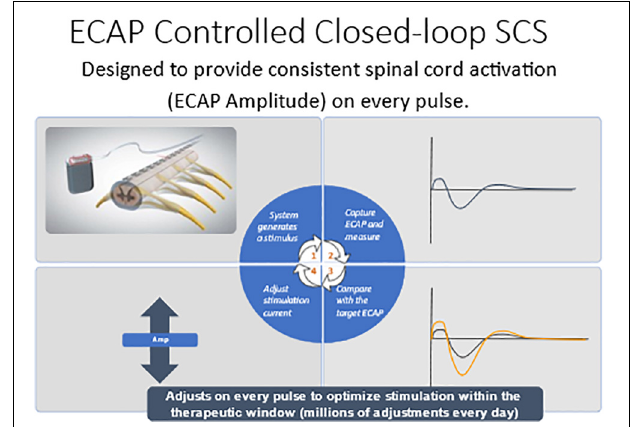
FIGURE 7 | Computer controlled ECAP controlled closed-loop SCS automatically adjusts current output to maintain a constant ECAP amplitude.